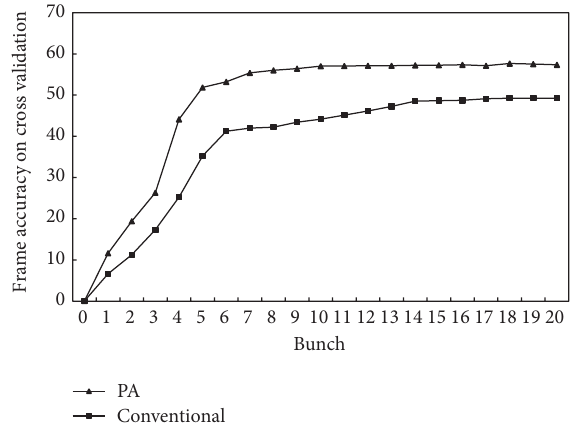
Figure 5: Changes of frame accuracies on cross